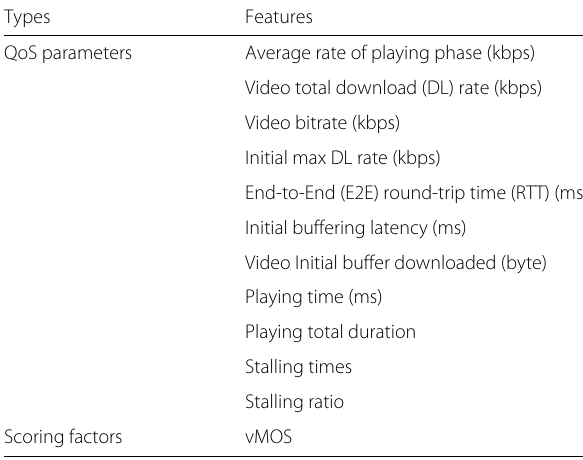
Table 2 Description of dataset